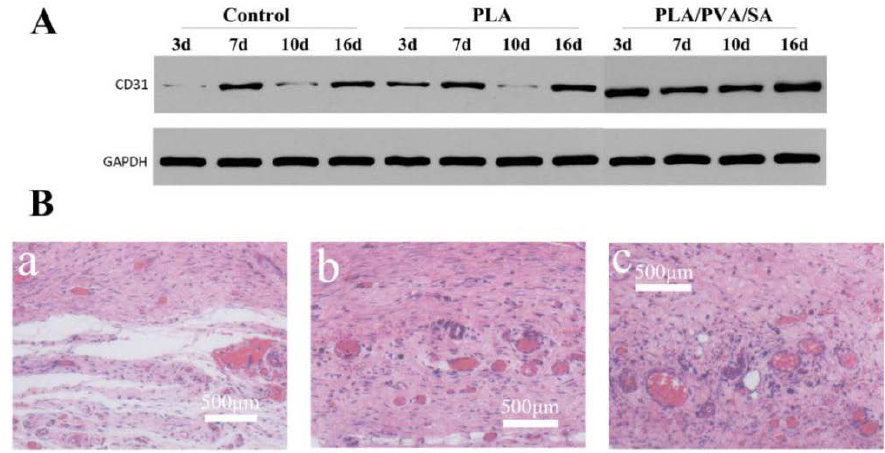
Figure 11. ( A ) Western blot of CD31. ( B ) Images of vessel formation of the wound at 16 days; ( a ) control; ( b ) PLA group; ( c ) PLA/PVA/SA group.